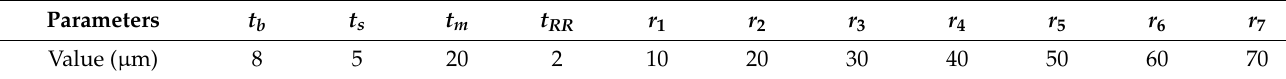
Table 1. The geometrical parameters of the designed unit cells.